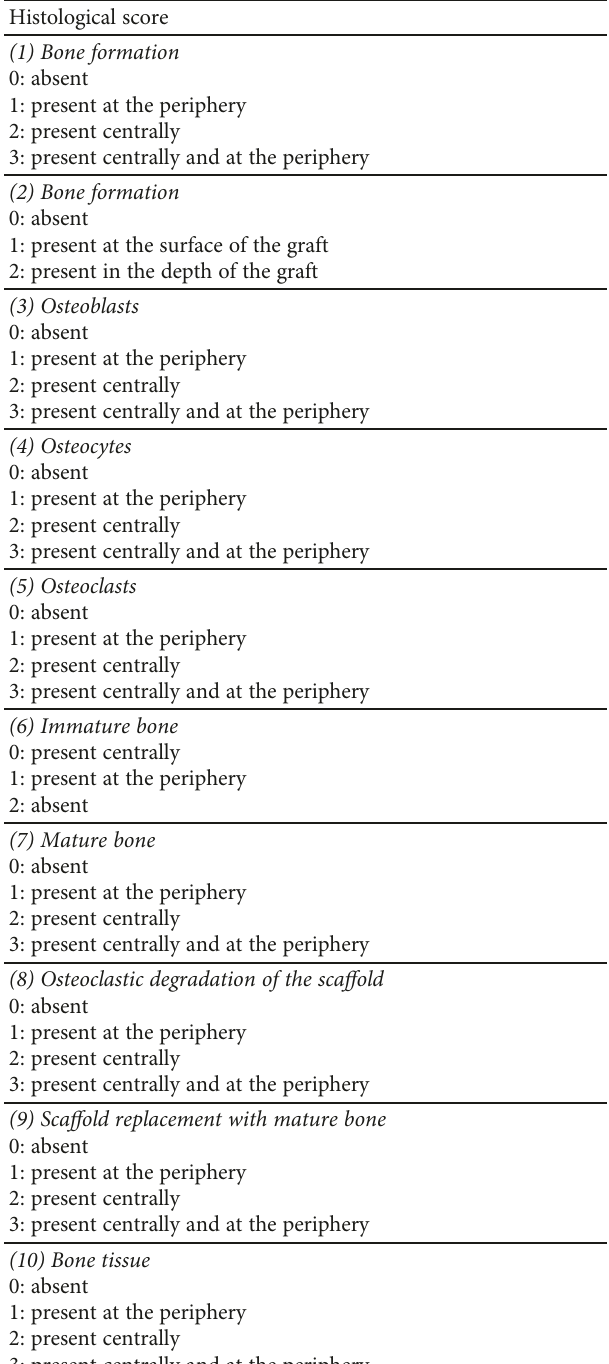
Table 1: Histological evaluation record. Histological